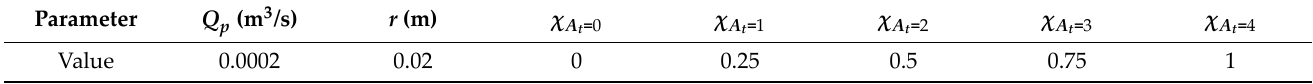
Table 2. Parameters related to pump’s